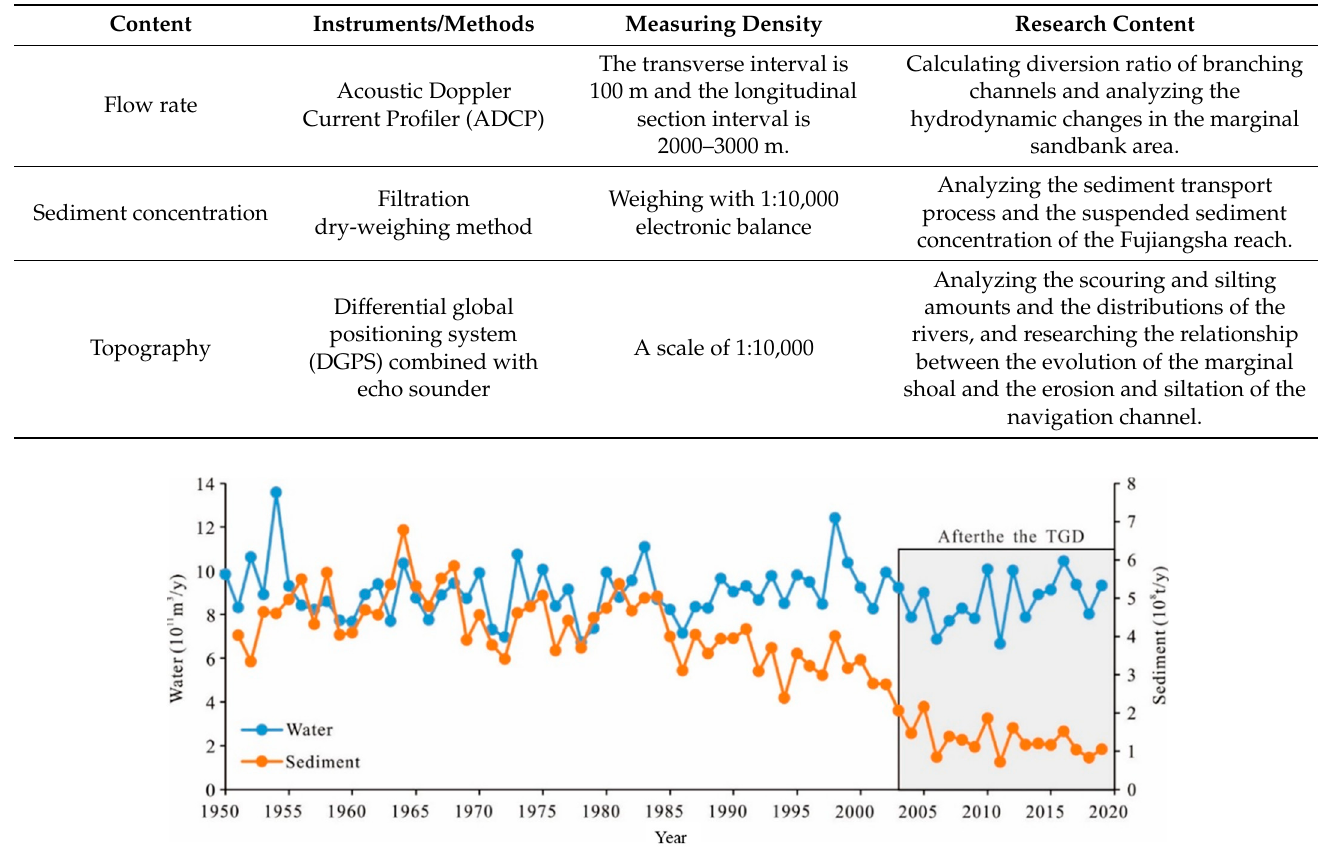
Table 1. Materials used in the study and parameter comparison.